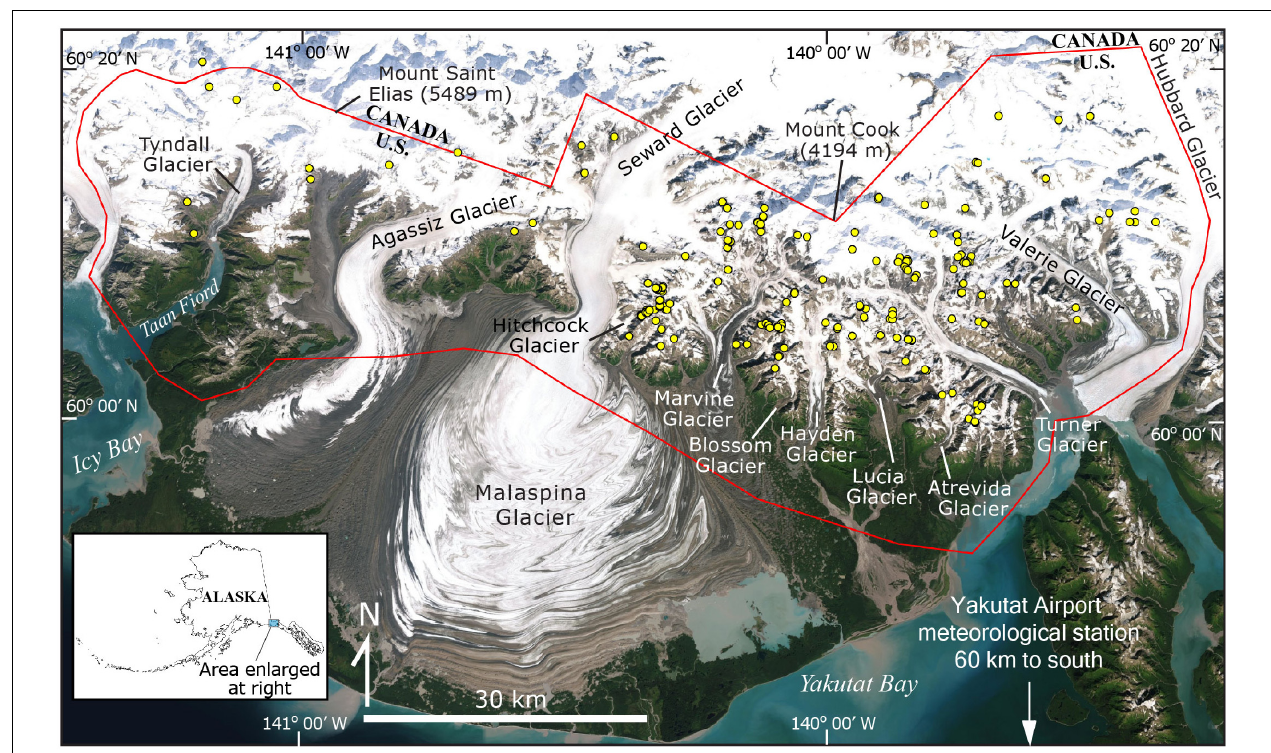
FIGURE 1 | Map of the Saint Elias study area (red polygon) in Alaska, showing locations of rock avalanches mapped between 1984 and 2019 (yellow dots).